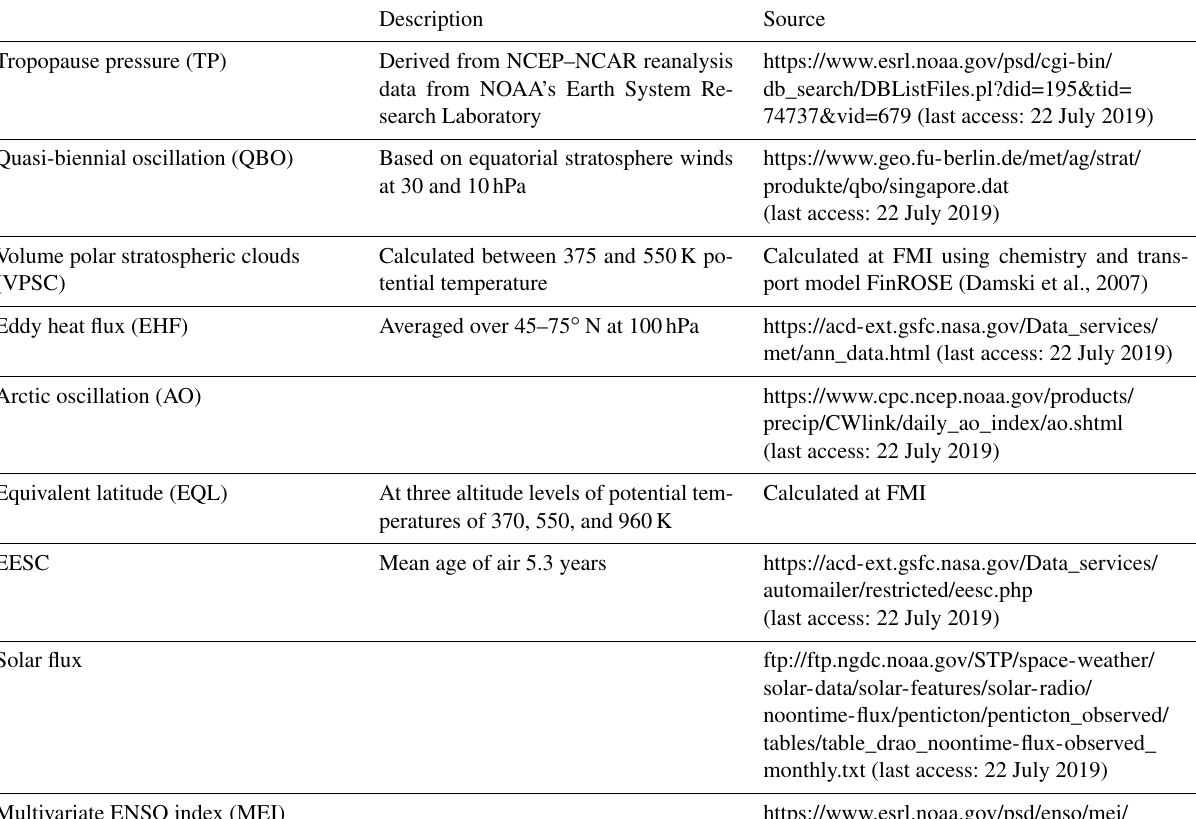
Table 1. Proxies used in the stepwise multiple regression performed in this study to explain variance in the total column ozone amount. Description